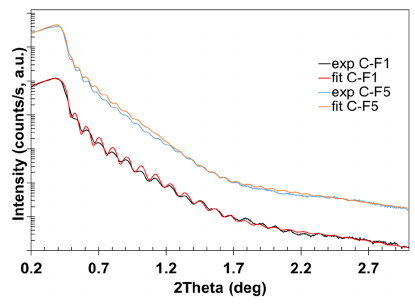
Figure 2. Typical XRR and simulation curves for C ‐ F1 and C ‐ F5 films synthesized at laser fluences of 2 and 6 J/cm 2 , respectively.